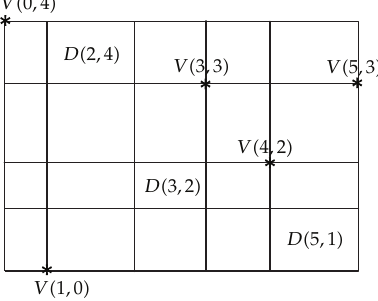
Figure 4: A rectangular partition Δ a × b , a (cid:5) 5, b (cid:5)